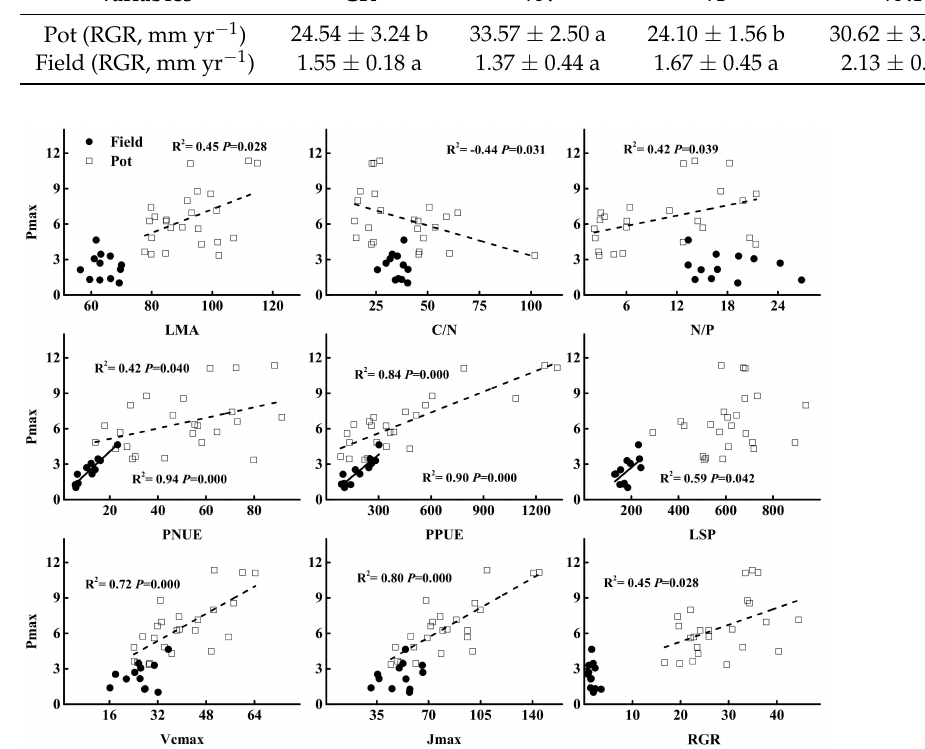
Figure 5. Relationships between the light-saturated photosynthesis rate (Pmax) and leaf traits, including leaf mass per area (LMA), C/N, N/P, PNUE, PPUE, light saturation points (LSP), Vcmax, Jmax, and relative growth rates (RGR) of Schima superba under field and pot experimental nitrogen and phosphorus addition (Field, • ; Pot, (cid:3) ). Notes: each point indicates one